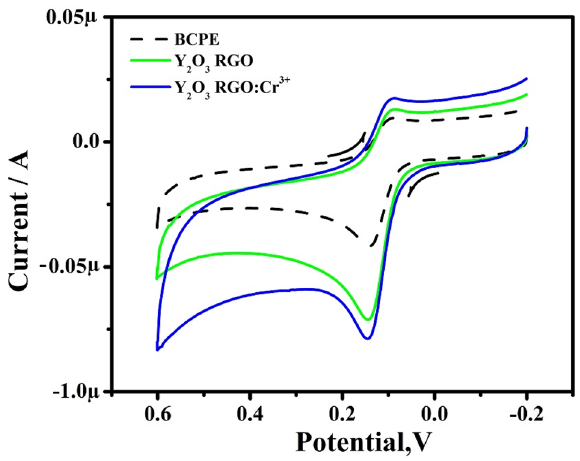
Figure 5. CVs of 10 μM DA in 0.2 M PBS solution of pH 7.4 at scan rate 50 mVs -1